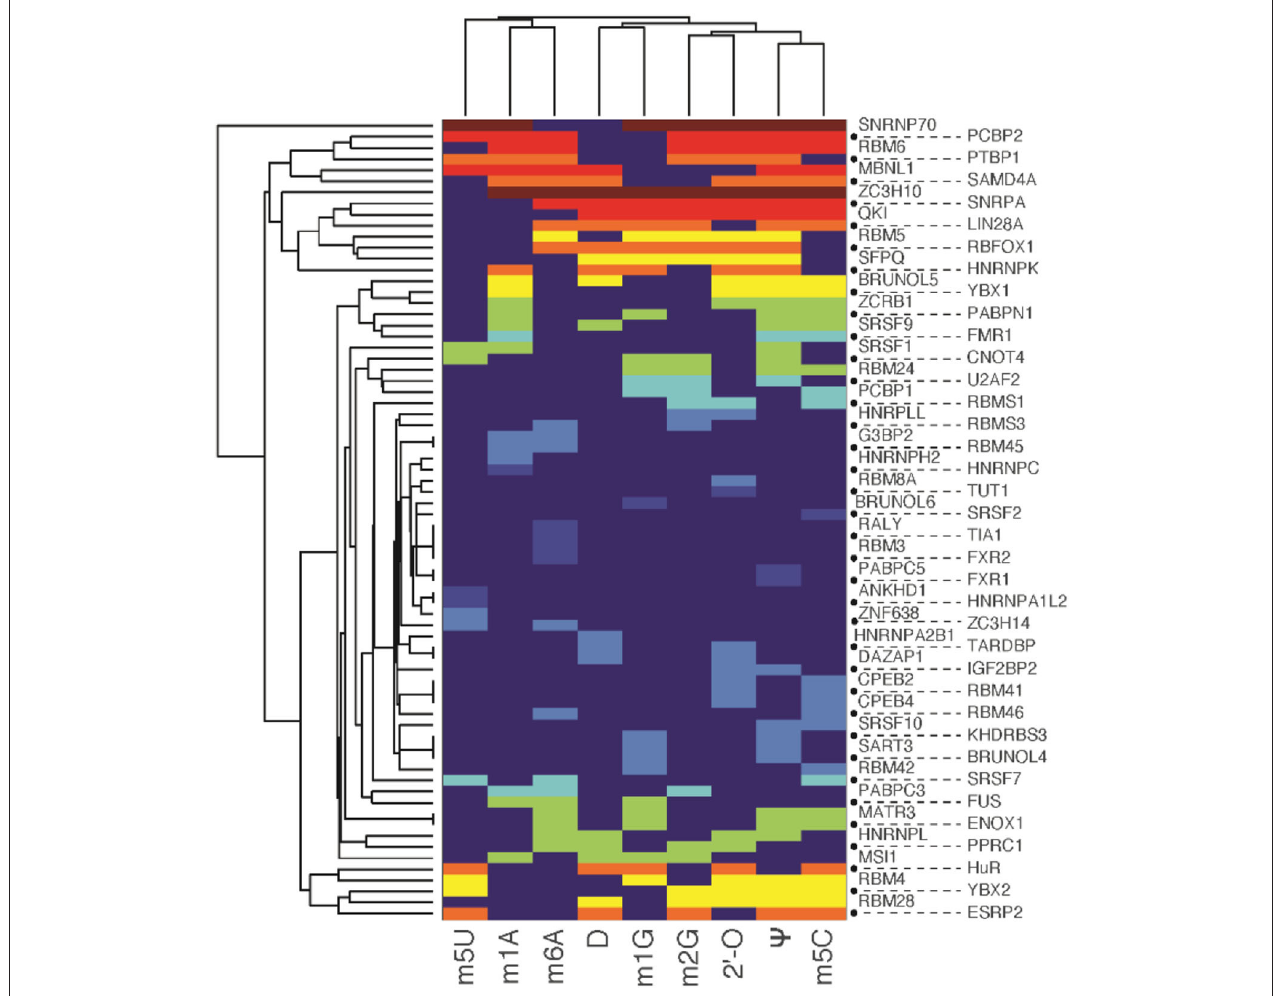
FIGURE 7 | Clustergram analysis (heatmap) of RNA-binding proteins identified to most likely interact with different transcriptome modifications. The color represents the significance with which they are found to be unique to these mRNA modifications by MEME-ChIP. The significance goes from lowest to highest as color varies from blue to